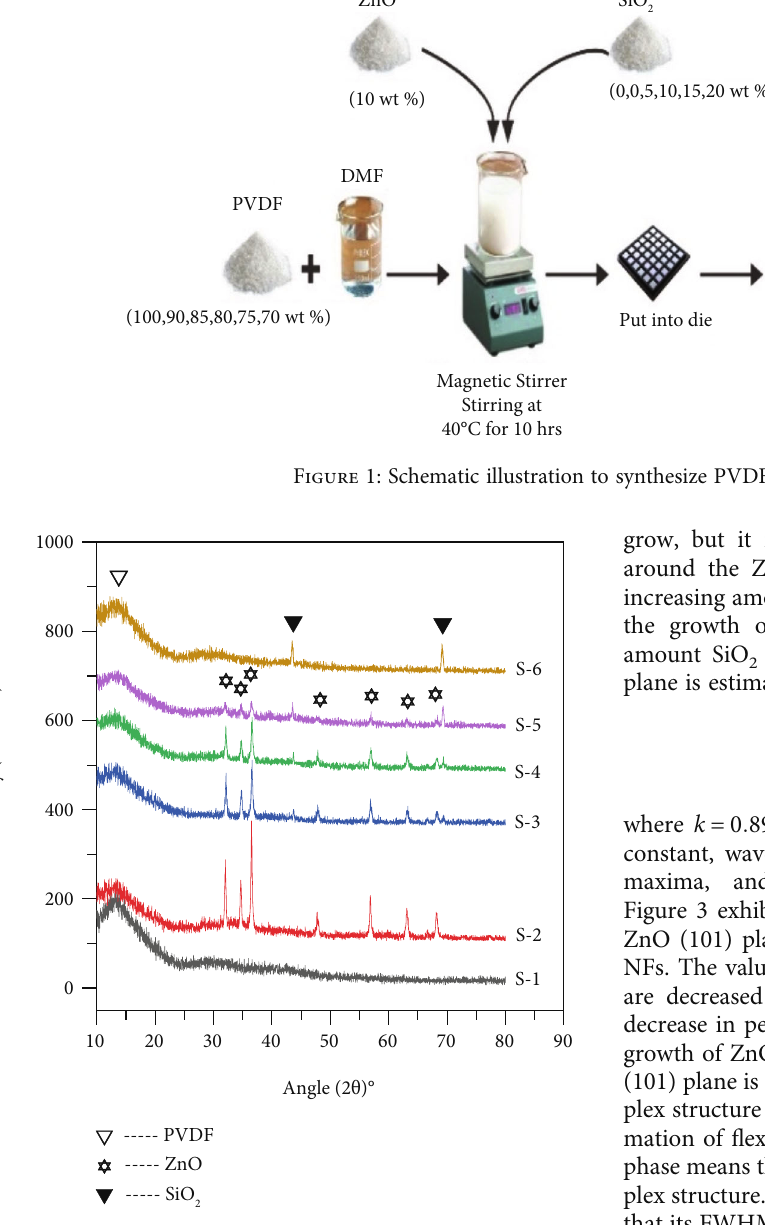
Figure 2: XRD patterns of PVDF and PVDF-based NC FSs synthesized for various wt.% of silica